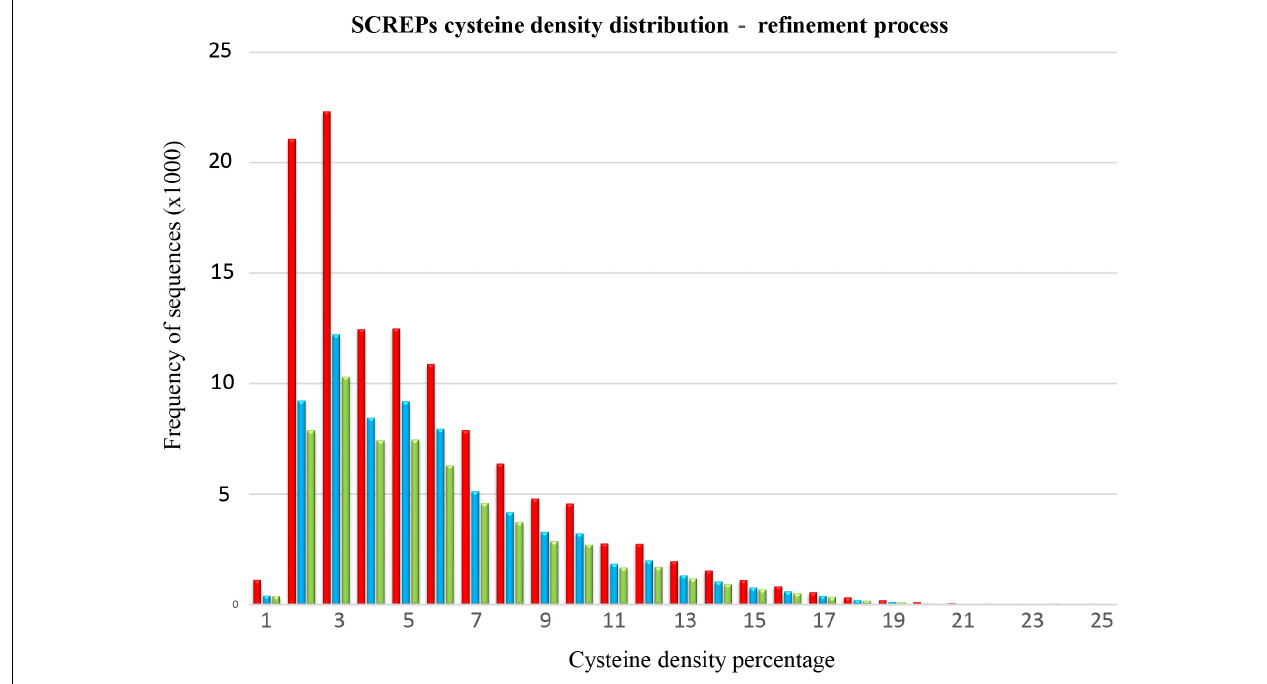
FIGURE 4 | SCREPs cysteine density distribution. An overlay of the cysteine density distribution of the three intermediate SCREP datasets demonstrating the refinement process, one; the raw output of the SCREPs processing algorithm “SPA” (red), two; after the removal of identified non-SCREP domains (blue), and three; the final non-redundant refined SCREPs dataset processed using cd-hit